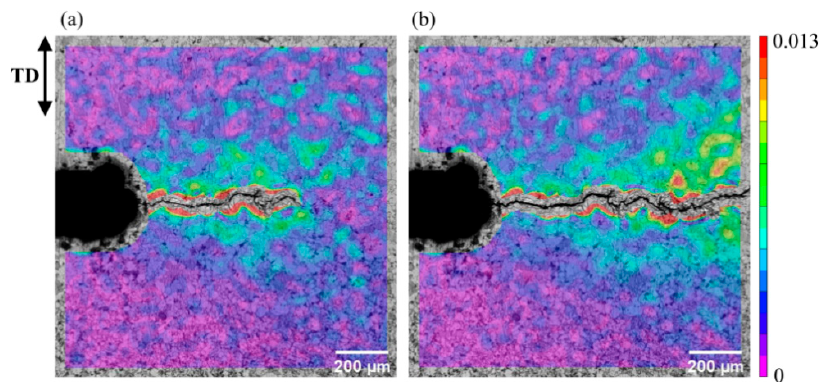
Figure 12. Von Mises strain fields of the TD1 specimen under a 10 × objective lens: ( a ) a = 1.25 mm,